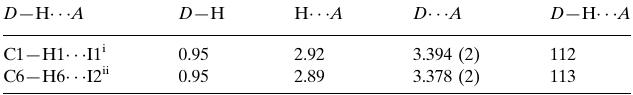
Hydrogen-bond geometry (A˚ , (cid:2)